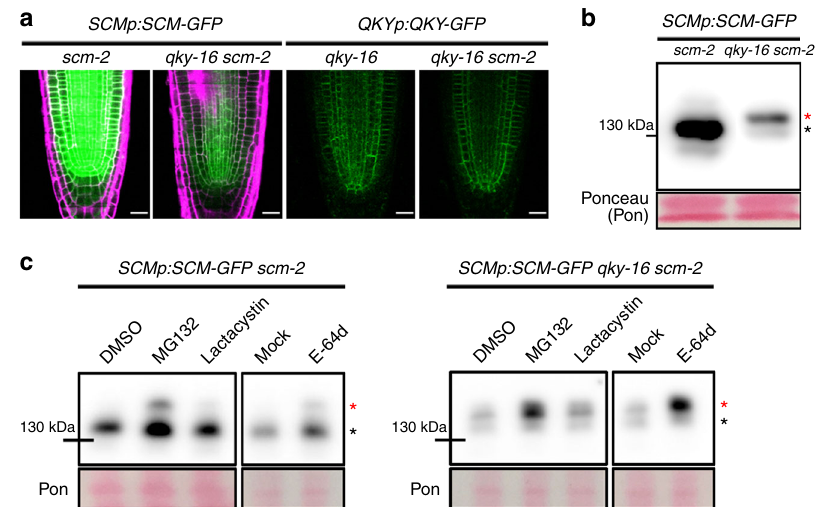
Fig. 5 QKY regulates the level of SCM protein in the root. a GFP accumulation in the developing root meristem of various plants harboring SCMp:SCM-GFP (left) and QKYp:QKY-GFP (right) translational fusions. Bar = 20 μ m. b Western blot analysis to examine the SCM-GFP level using monoclonal anti-GFP antibodies. c Western blot analysis to examine the SCM-GFP level. Four-day-old seedlings were incubated with MG132 (50 μ M), lactacystin (50 μ M) or E- 64d (20 μ M) for 2 h. Total protein extracts were subjected to immunoblotting using monoclonal anti-GFP